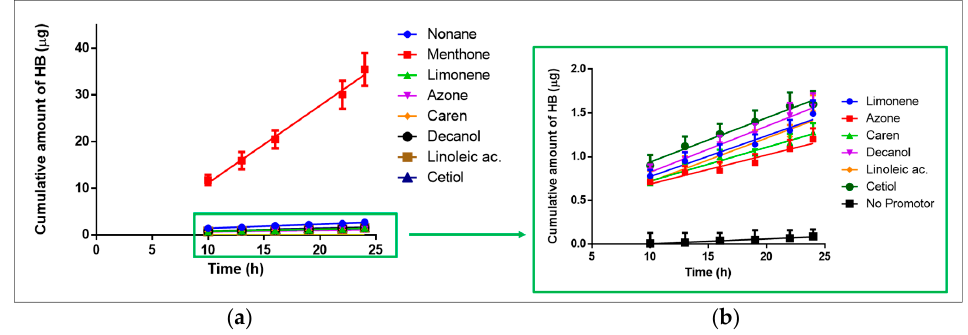
Figure 2. Cumulative permeated amount of HB versus time (h) represented as mean ± SD of six experiments. ( a ) Effect of permeation enhancers in the permeation of HB through skin; ( b ) zoom of the enhancers with lower effect in HB permeation and HB with Transcutol ® (No promotor). Table 4. Skin permeation parameters of HB in the presence of tested promoters. Data are represented as median (min–max).